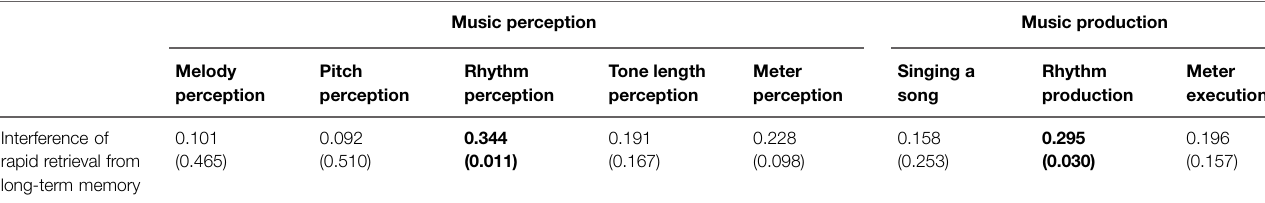
TABLE 5 | Associations among interference of rapid retrieval from long-term memory and the subtests of music perception as well as the subtests of music